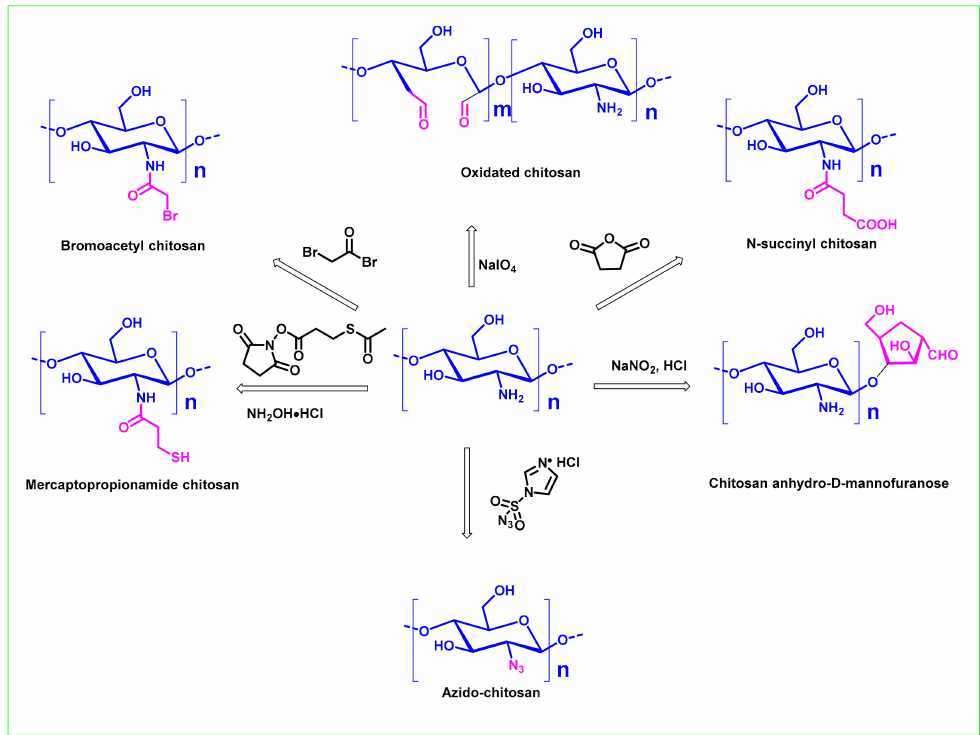
Figure 4. Functional group conversion strategies commonly used in the synthesis of chitosan